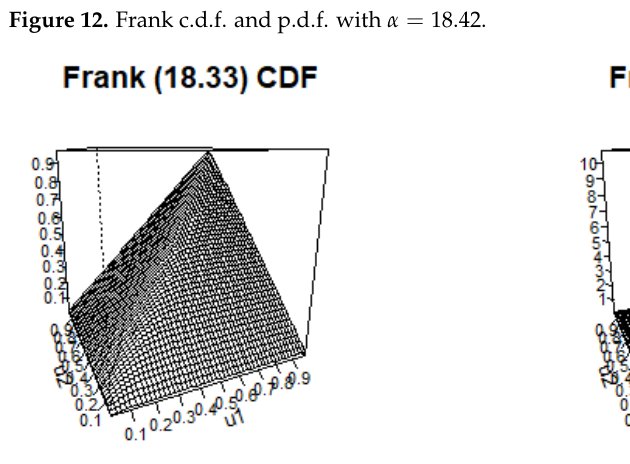
Figure 13. Frank c.d.f. and p.d.f. with α =